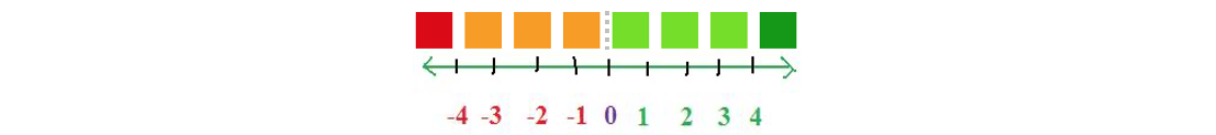
Figure 6. The nutritional score presented behind a traffic-light scale.